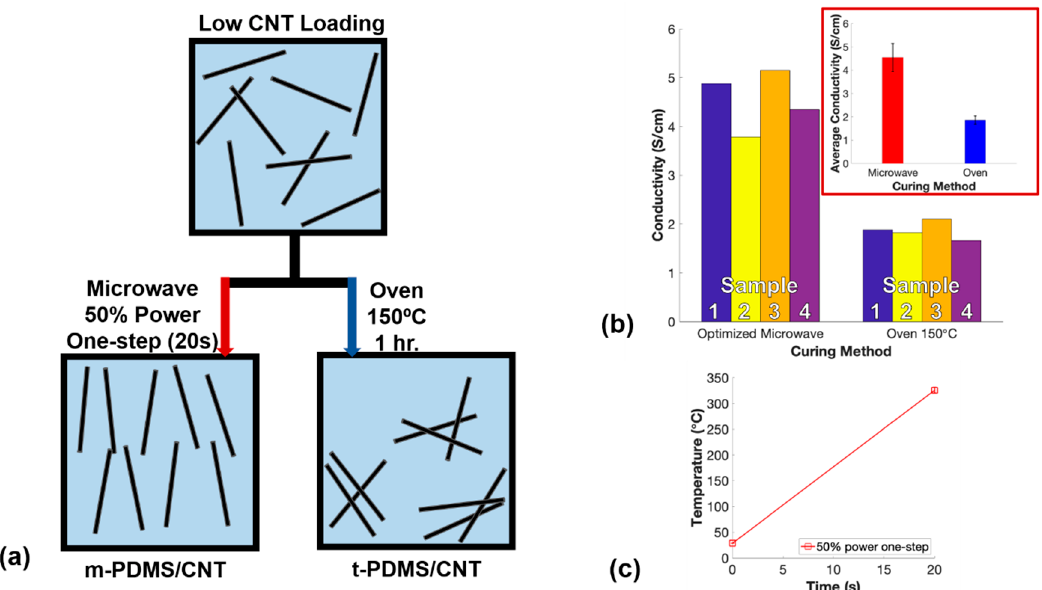
Figure 9. Optimized comparison—( a ) Schematic showing improved CNT dispersion and alignment for nanocomposites cured with optimal microwave parameters, ( b ) conductivity of each set of samples for optimal m-PDMS / CNT and t-PDMS / CNT, and ( c ) average temperature measurements after microwave curing 1 wt.% PDMS / CNT for one-step at 50% microwave power.